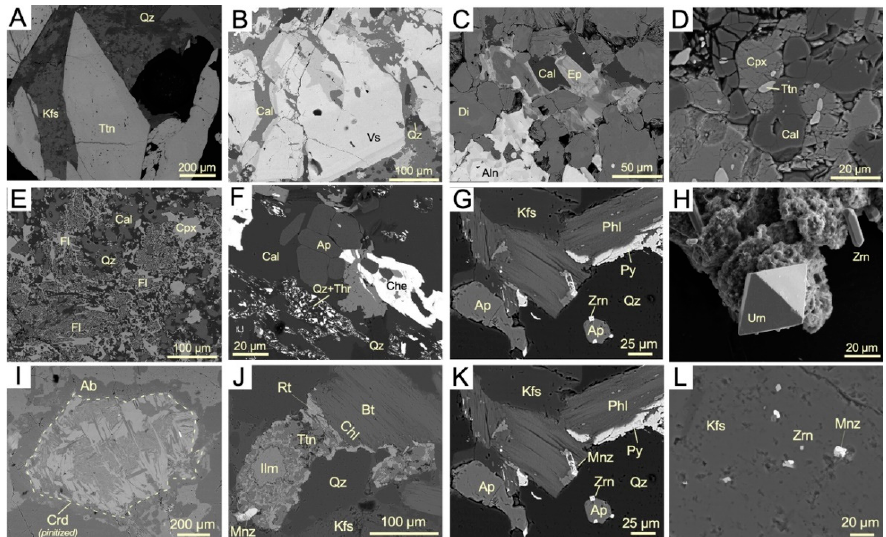
Figure 3. Backscattered electron images showing ( A ) Euhedral zoned titanite (Ttn) with relict K ‐ feldspar (Kfs) and quartz (Qz), in the endoskarn. ( B ) Zoned vesuvianite (Vs) with fractures filled by REE ‐ enriched overgrowth. ( C ) Late allanite (Aln) replacing epidote (Ep) in diopside ‐ rich exoskarn. ( D ) Dissolution texture of diopside (Di) and titanite, with late calcite (Cal). ( E ) Fluorite (Fl) + calcite + quartz + diopside pseudomorphs in a clinopyroxene ‐ rich exoskarn. ( F ) Pseudomorph of (Thr)thorite + quartz after cheralite (Che), with apatite (Ap), quartz and calcite in (Cpx)clinopyroxene ‐ rich exoskarn. ( G ) Metasomatic fluorapatite and zircon (Zrn) bordering metasomatized biotite (Bt) partially replaced by phlogopite (Phl) ( H ) Zircon and uraninite (Urn) on “spongy” titanite. ( I ) Pinitized cordierite (Crd) with albite (Ab) corona, in monzogranite. ( J ) Ilmenite (Ilm) replaced by titanite and rutile (Rt) related to biotite replaced by chlorite (Chl). ( K ) Apatite, zircon, pyrite (Py) and monazite (Mnz) in altered granite. ( L ) Metasomatic monazite and zircon in secondary K ‐ feldspar. Mineral abbreviations from reference [20].